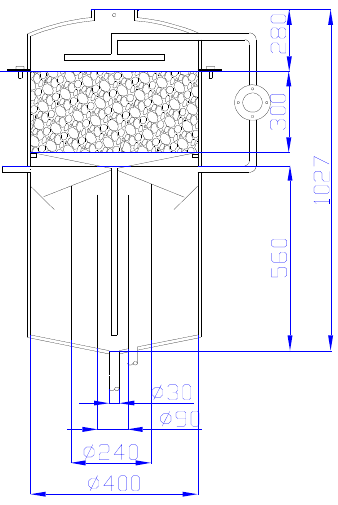
Figure 1. Main dimensions of the multi-section hybrid anaerobic reactor (M-SHAR).